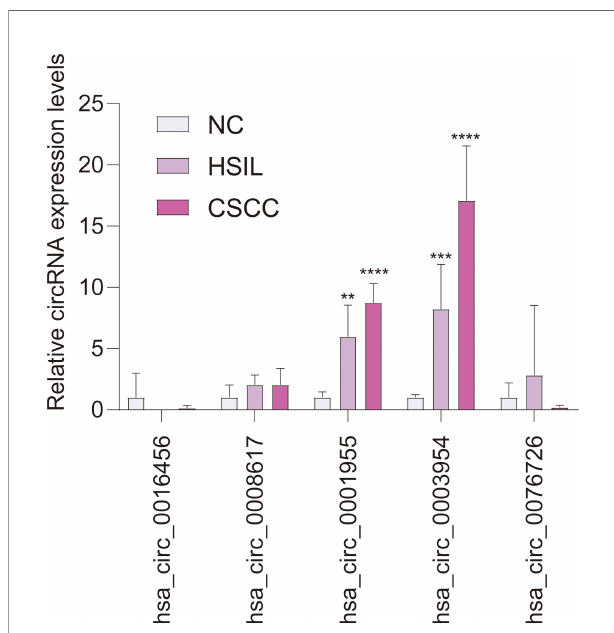
FIGURE 8 | qRT-PCR results of 5 circRNAs in clinical specimens. For qRT- PCR, target gene expression was normalized to GAPDH expression ( D Ct). The results are presented as the mean ± SD (NC-qRT-PCR, n = 5; HSIL- qRT-PCR, n = 5; CSCC-qRT-PCR, n = 5). ** p < 0.01, *** p < 0.001, **** p < 0.0001. SD, standard